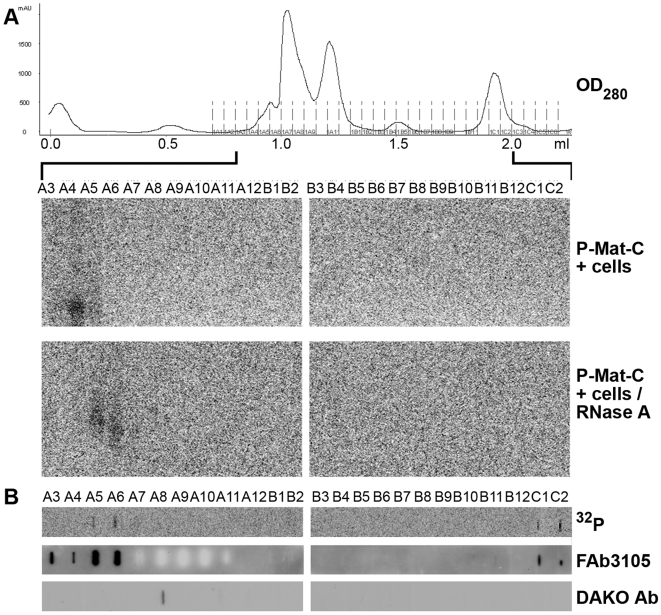
Analysis of Mat-C after nuclear import by Superdex 75 columns and native agarose gel electrophoresis.A. Upper panel: OD280 of the elution profile. The profile remained unchanged when cells were treated with RNase A. Middle panels: phosphoimager scan after native agarose gel electrophoresis. Lower panel: phosphoimager scan after native agarose gel electrophoresis using fractions from P-Mat-C added to RNase A-treated cells. B. Analysis of P-Mat-C from RNase A-treated cells by dot blot. Upper panel: phosphoimager scan, middle panel: detection by FAb3105, lower panel: detection by DAKO Ab.